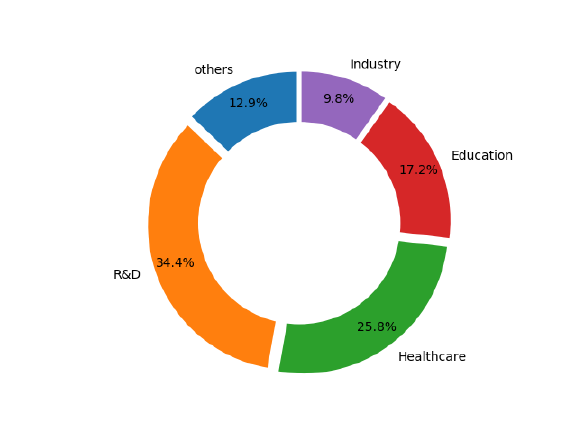
Figure 8. Distribution of developed fields.